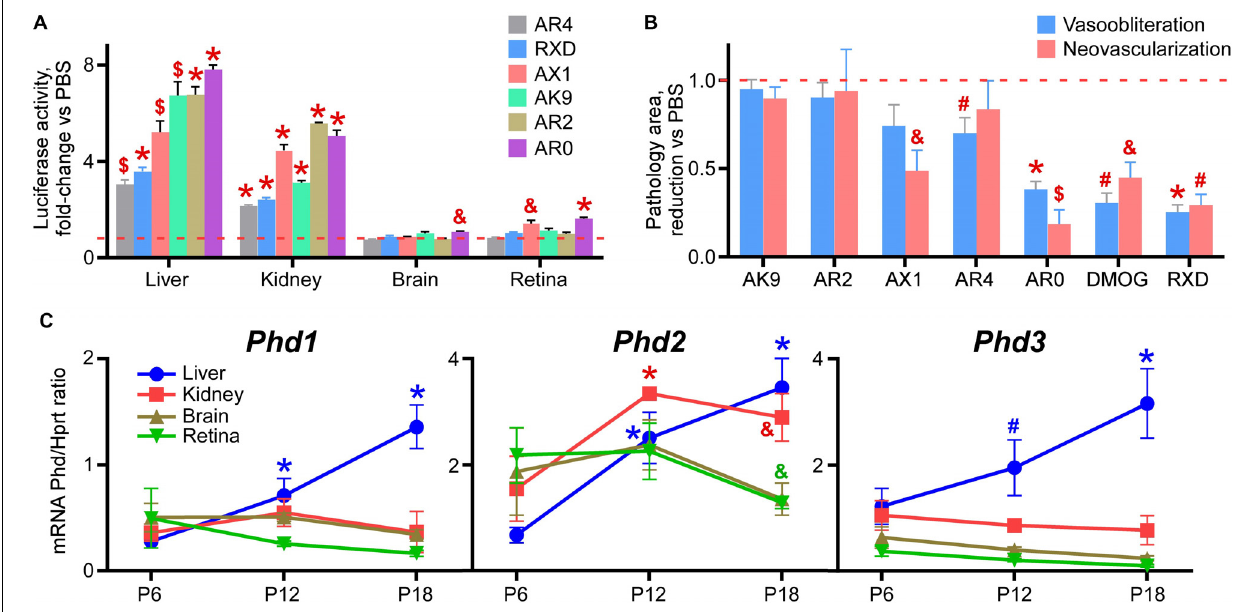
FIGURE 4 | Rank order of the tested drug-like compounds. (A) Luciferase activity in tissue homogenates of P8 Luc-ODD mouse pups 3 h after injections of AR4 (40 µ g/g), Roxadustat (RXD, 10 µ g/g), AX1 (40 µ g/g), AK9 (40 µ g/g), AR2 (40 µ g/g) or AR0 (20 µ g/g) plotted as fold-change vs control PBS injection (red dashed line). Number of replicates is given in Figures 1–3 . (B) Cumulative quantitative analysis of all retinal flatmount images exemplified in Figures 1–3 presented as a drug-induced reduction in avascular or neovascular retinal area from the control PBS treatment (red dashed line). Number of replicates is given in Figures 1–3 . (C) Organ-specific developmental expression of Phd1 , Phd2 , and Phd 3 plotted as corresponding mRNA levels normalized to mRNA levels of Hprt . Color of the p value marker corresponds to color of the line. n = 6 for each experimental condition and each